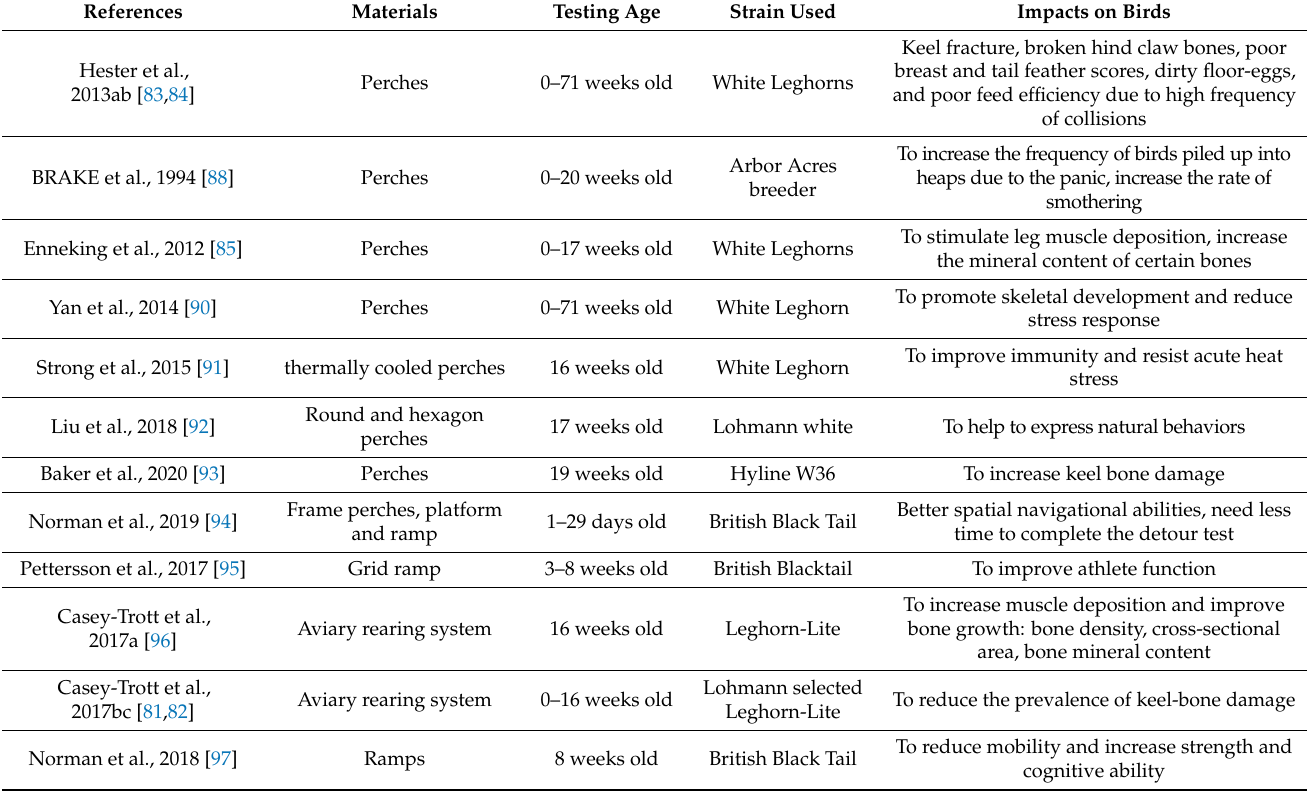
Table 3. Furnishings used for locomotion in various studies on